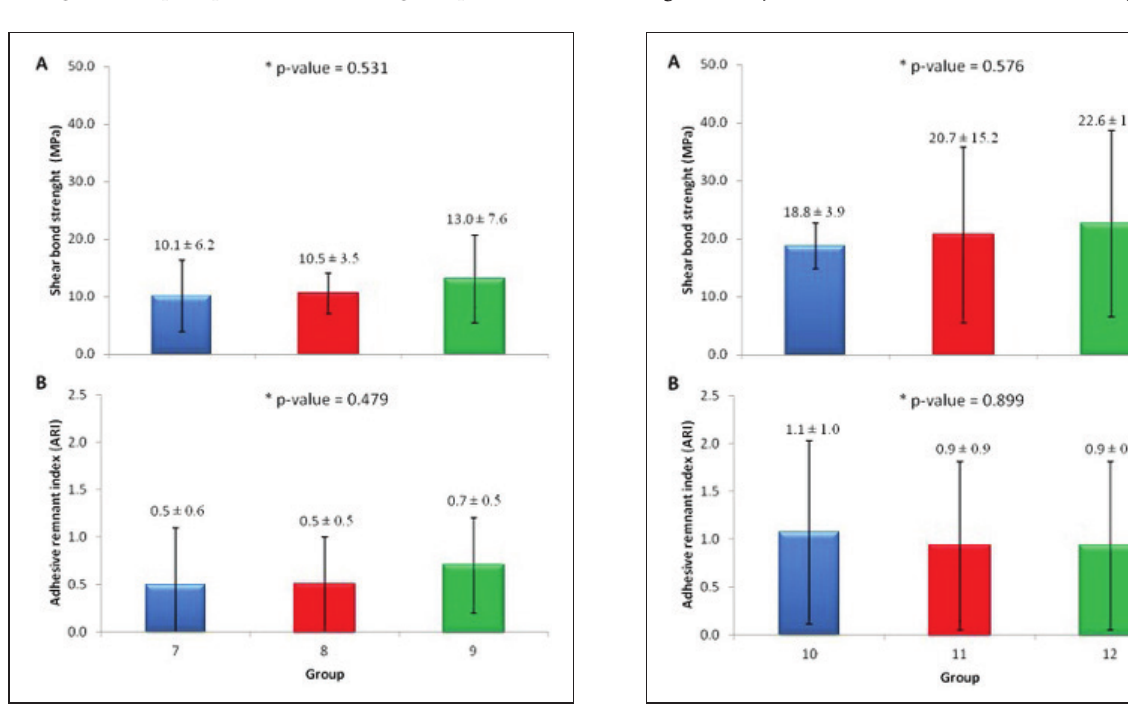
Figure 3. Comparison of shear bond strength (A) and ARI (B) between groups. Columns represent means, and error bars the standard deviations.